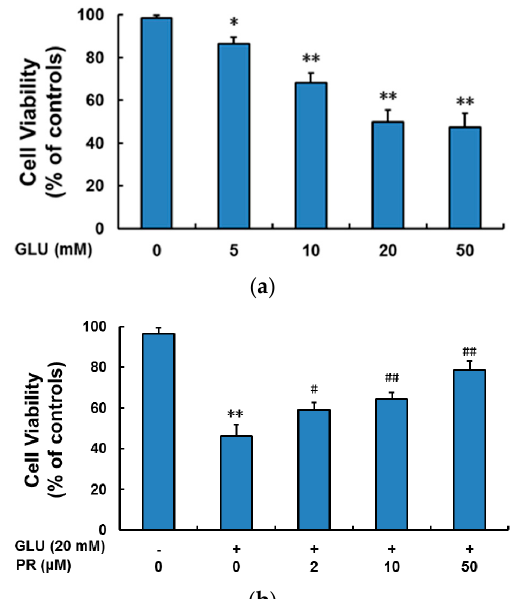
Figure 1. The neuroprotective effect of puerarin against the glutamate-induced cytotoxicity in the differentiated Y-79 cells. ( a ) Cells were exposed to glutamate (5–50 mM) for 24 h without puerarin pre-treatment; ( b ) cells were pre-treated with puerarin (0, 2, 10 and 50 μ M) for 24 h and then exposed to 20 mM glutamate for 24 h. After treatment, cell viability was determined by MTT analysis. All data were expressed as mean ± SD of three experiments and each experiment included triplicate repeats. * p < 0.05, ** p < 0.01 vs. control group; # p < 0.05, ## p < 0.01 vs. glutamate-treated group. GLU: glutamate; PR: puerarin.